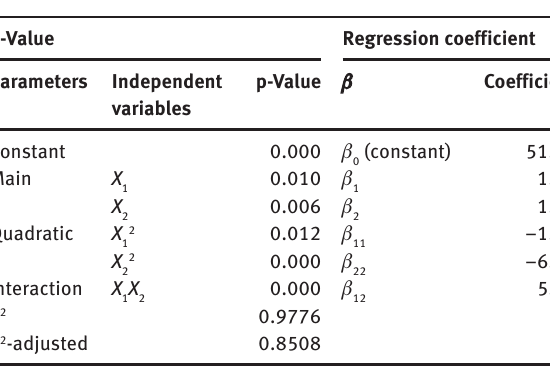
Table 5: p-Values and regression coefficients for the generated model based on the yeast strain NCYC 4109.